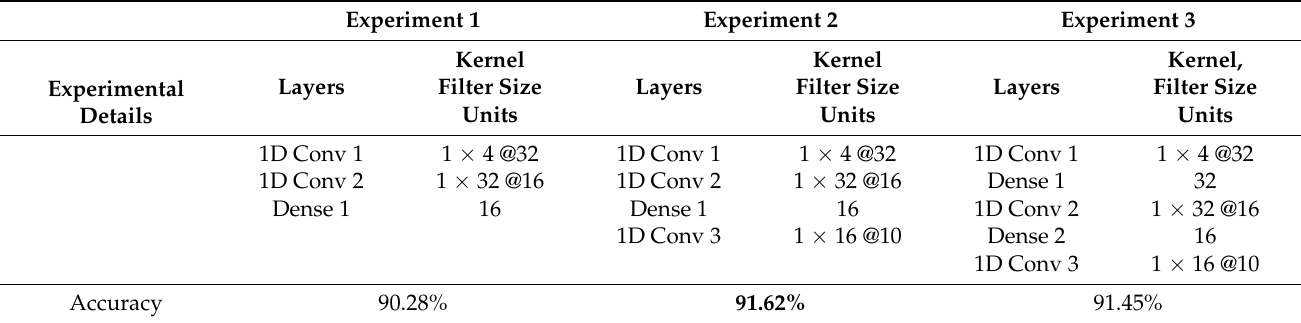
Table 4. Accuracy (in %) comparison of proposed models composed of different hyperparameters with deep-feature generation (layers, kernel, filter size, and units).